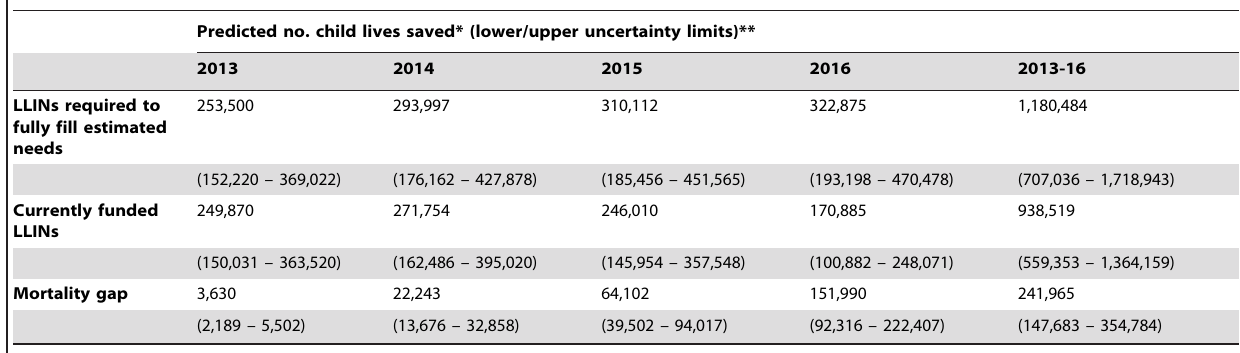
Table 1. Sensitivity analyses of the predicted number of under-five lives that could be saved with full funding for all LLINs needed versus currently funded LLINs, depending on malaria mortality